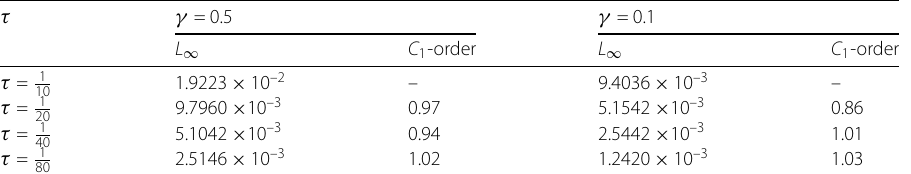
Table 13 C 1 -order of convergence for Example 2, when h = 1